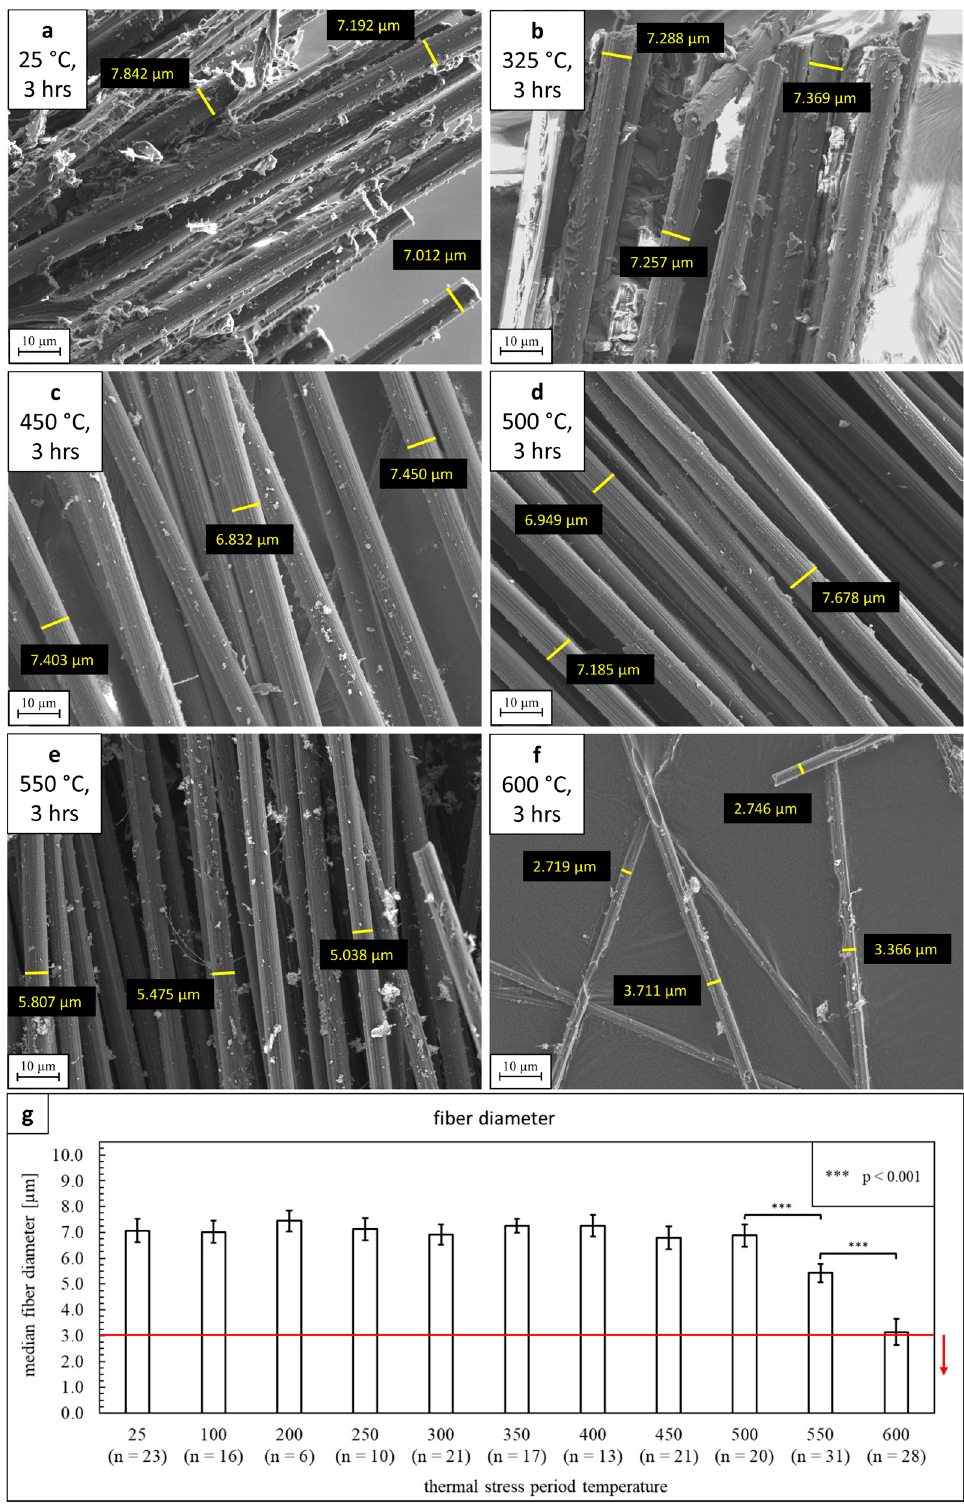
Figure 4. SEM micrographs (1000× magnification). Morphology of epoxy resin-coated carbon fibers extracted from thermally stressed C 3 (25–600 °C, air atmosphere, 3 h, ( a – f )). Pitting processes occurring at ≥ 550 °C lead to a decrease in the median fiber diameter ( g ). WHO fiber diameters <3 µm are indicated by a red line and arrow.